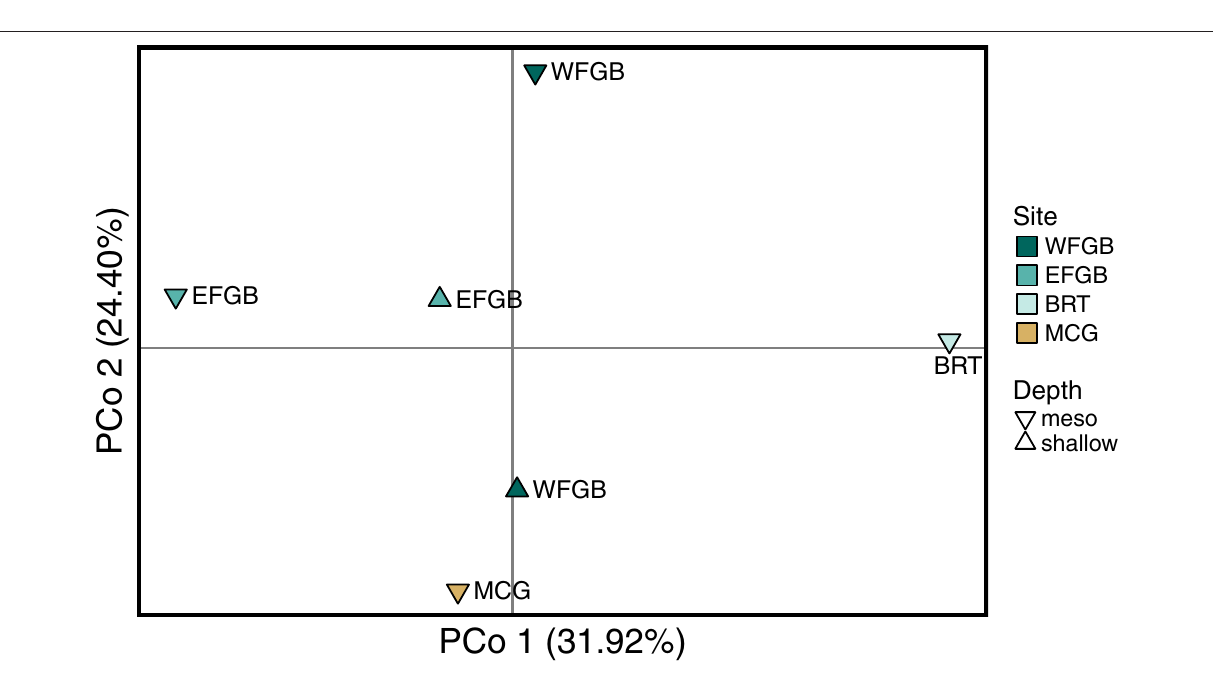
FIGURE 3 | Principal coordinate analysis of Nei genetic distance (D A ) matrix generated from pairwise population differentiation comparisons. Samples from each population were first compared to generate a single eigenvector, represented by a single point in three-dimensional space, and the relative distance between populations approximates the degree of genetic differentiation. The three axes have been flattened to a two-dimensional representation and explain 73.48% of the total genotypic variation (Coordinate 1 31.92%, Coordinate 2 24.40%, Coordinate 3 17.16%). Color of each point corresponds to discrete